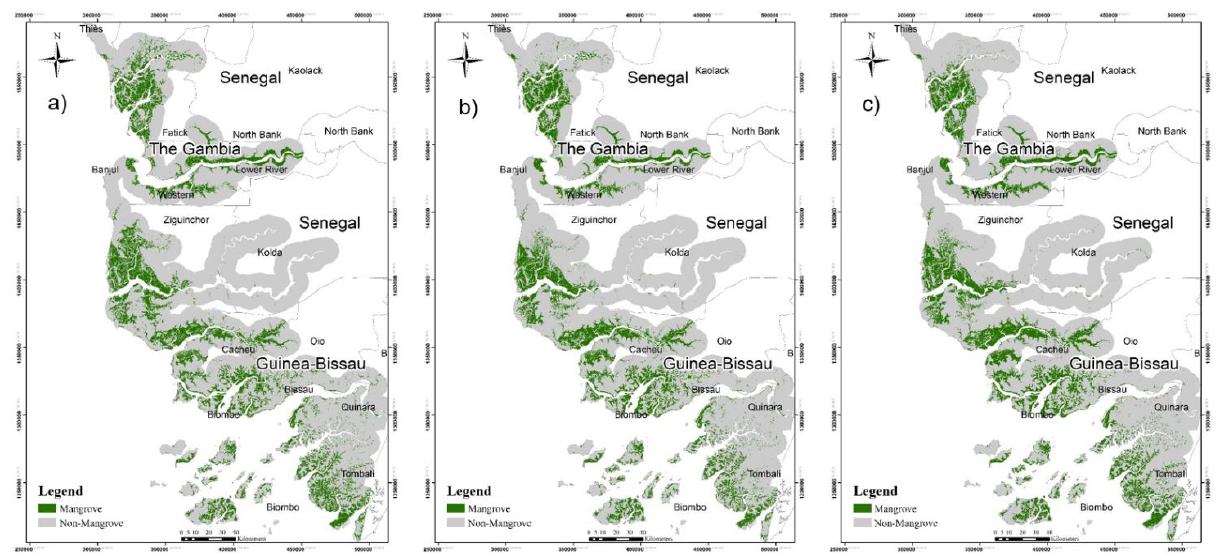
Figure 5. Spatial distriution of mangrove in the West and Central Africa derived from Landsat imagery in a) 1988, b) 2001, and c)